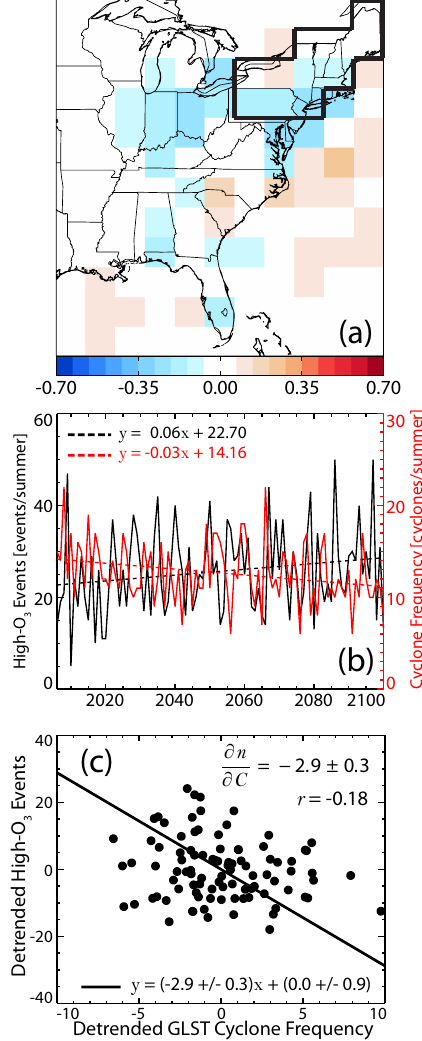
Fig. 8. Long-term trends and correlations between summer (JJA) 2006–2100 GLST cyclone frequency and high-O 3 events in the RCP 4.5 ∗ (X3 ∗ ) warming scenario in which ozone precursor emis- sions are held constant at 2005 levels. High-O 3 events are defined here as days where the 95th percentile in the 1986–2005 period is exceeded (see Sect. 4 for details). (a) Correlation of the yearly values between the number of high-O 3 events and the number of storms tracking through the GLST in summer (JJA); solid black line outlines the grid cells in the Northeastern US. (b) The num- ber of summer (JJA) high-O 3 events in the Northeastern US (black) and GLST cyclone frequency (red) as solid lines with significant trends ( p < 0 . 01) from a least-squares regression shown as dashed lines. Equations for significant trends are shown where x as the year subtracted by 2006 (the intercept given is for the year 2006). (c) Scatterplot of high-O 3 events ( n ) and GLST cyclone frequency ( C ) after removing significant trends shown in panel (b) . Solid black line is the reduced major axis regression of the detrended data indi- cating a sensitivity of ∂n/∂C = − 2 . 9 ± 0 . 3 with a correlation ( r ) of −